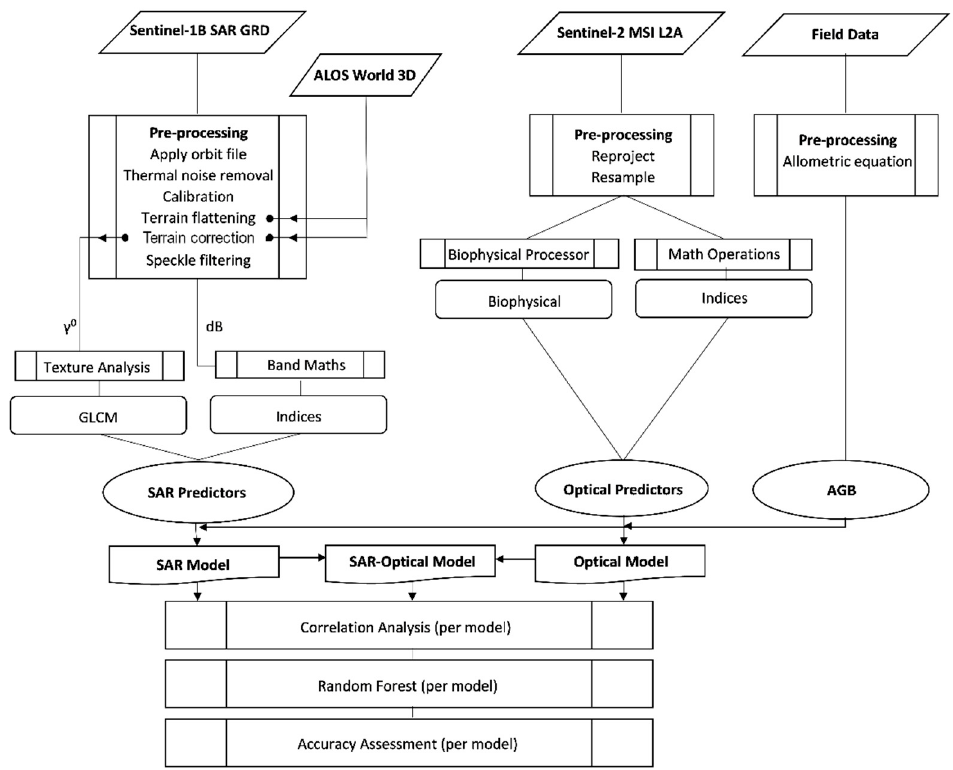
Figure 3. Flowchart of the workflow employed for the plot-level TSB (total stem biomass) estimation using Sentinel-1, -2 data, and RF modelling.